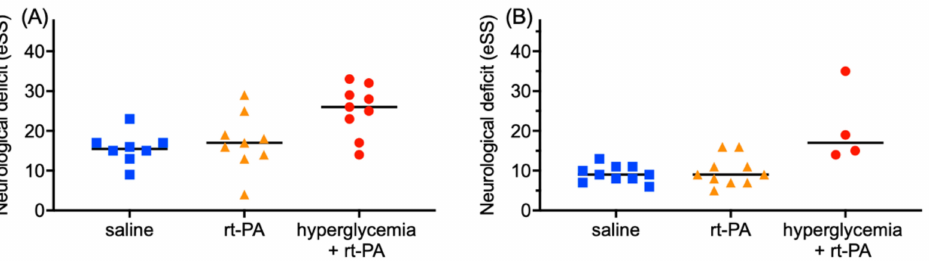
Figure 2. Neurological deficit 24 h after experimental treatment . ( A ) In the first substudy (treatment 24 h after index stroke), neurological deficit, assessed by a 42-point experimental Stroke Scale (eSS), differed significantly at the end of the observation period ( p = 0.02). A post hoc multiple comparison test showed that hyperglycemic mice treated with rt-PA had a significantly worse neurological outcome than the saline group as control ( p = 0.02). Comparing the neurological outcome in rt-PA and saline-treated mice did not reveal a significant difference ( p > 0.99). ( B ) In the second substudy (14 days after index stroke), the neurological outcome differed significantly. A post hoc multiple comparison test showed that hyperglycemic mice treated with rt-PA had a significantly worse neurological outcome than the saline group as control ( p = 0.02) and normoglycemic mice treated with rt-PA ( p = 0.04). The values of each single mouse and the medians are depicted. Statistical significance was assessed with a Kruskal–Wallis test with Dunn’s multiple comparison